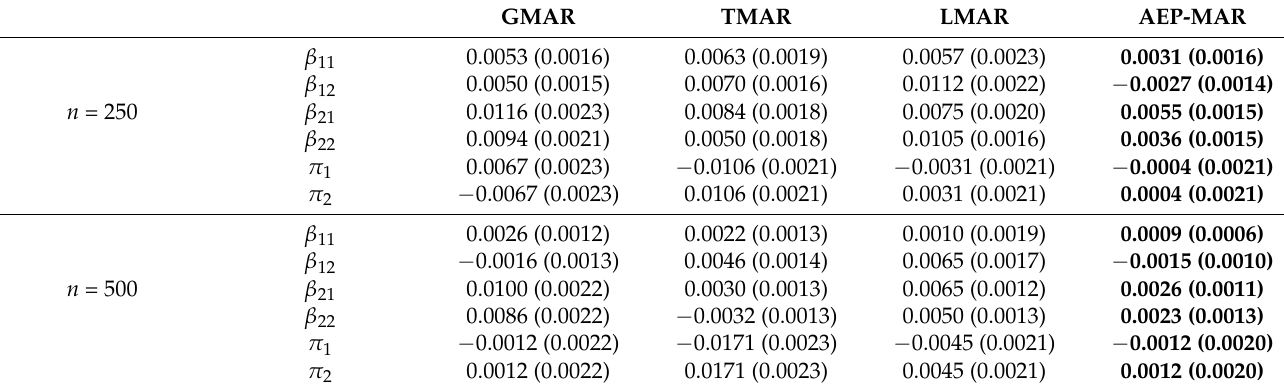
Table 6. Simulation results for Scenario 4 .